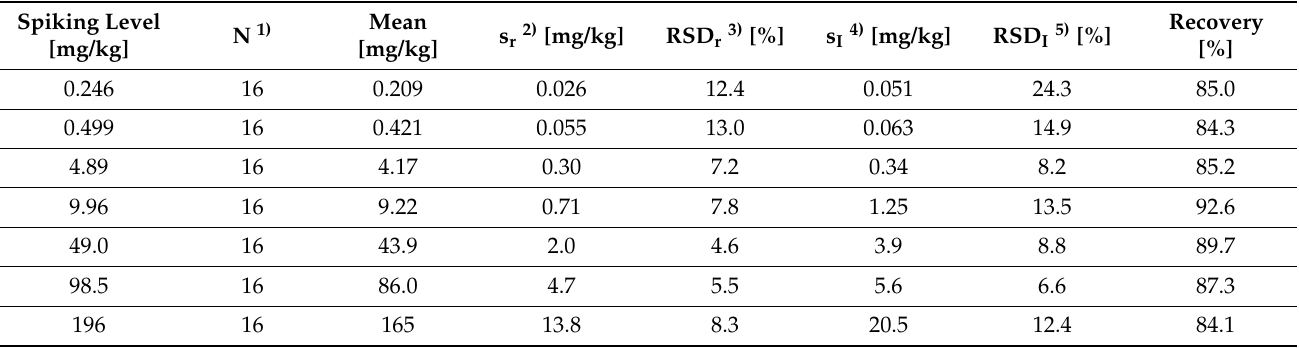
Table 4. Recoveries, repeatability, and intermediate precision obtained by DHS-VTT-GC-MS analysis of thymol in beeswax using external quantitation.